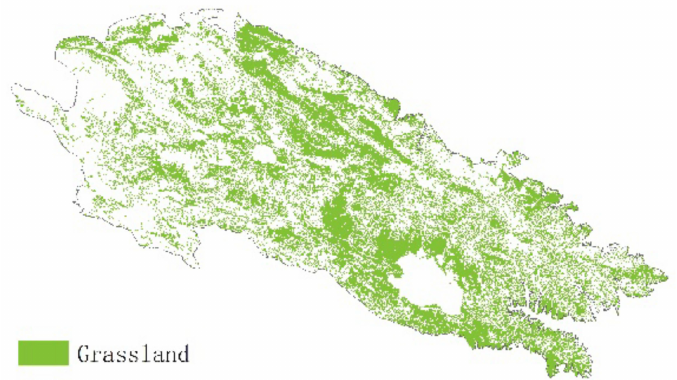
Figure 2. The distribution of remaining grassland in the study area from 2000 to